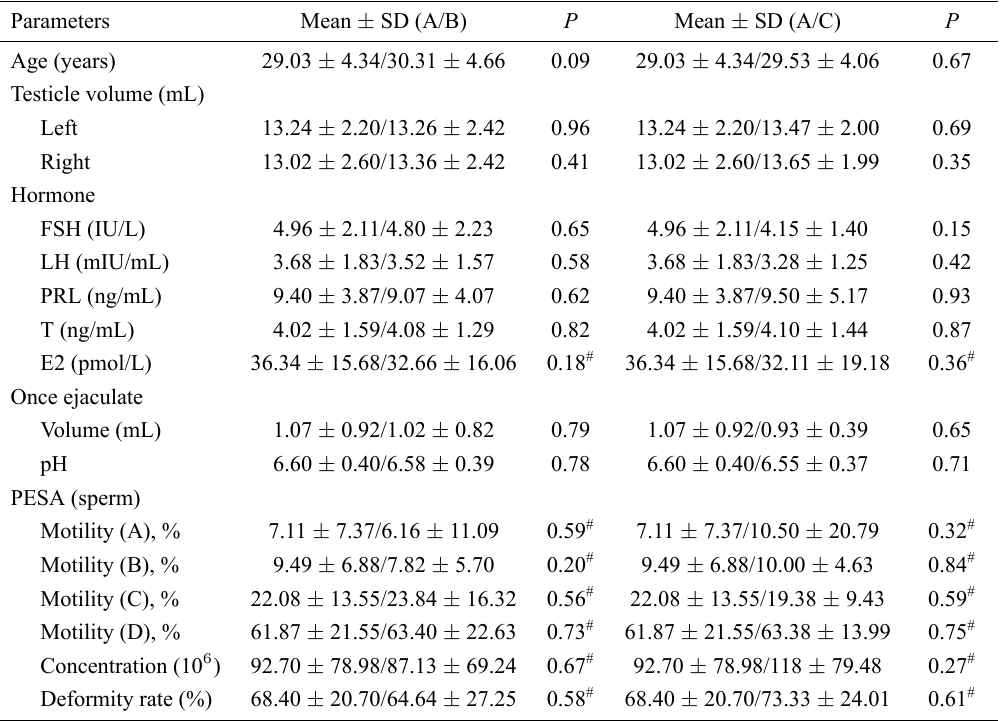
Table 2. General characteristic of the 172 cases.